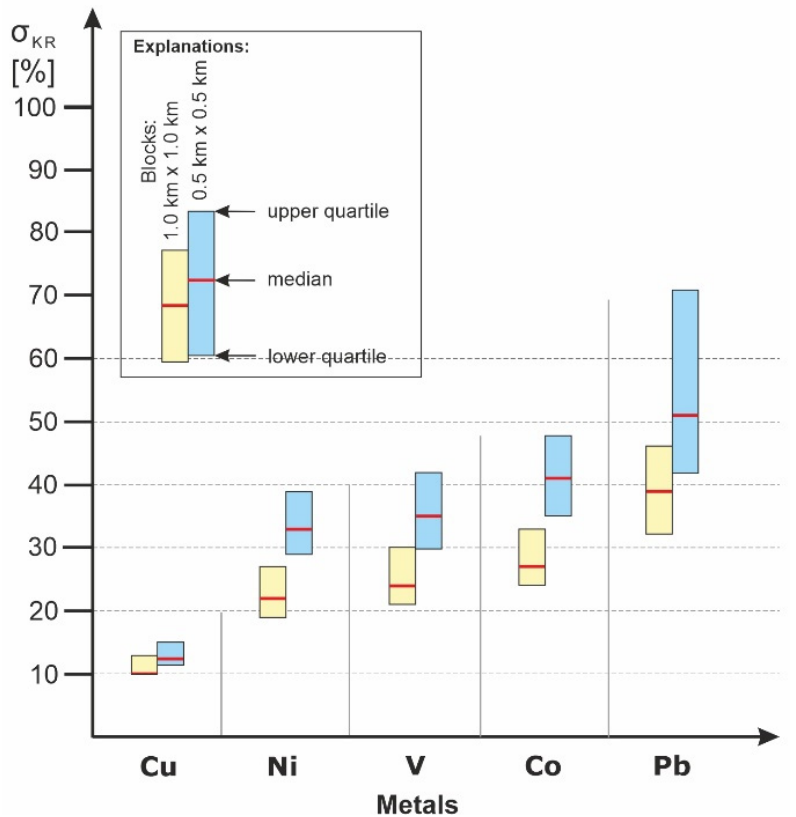
Figure 13. The ranking of the accuracy of the estimation of the average abundance of Cu and accompanying elements in blocks with an area of 0.25 and 1.0 km 2 in the Rudna deposit, expressed with the use of quartiles of standard block kriging relative error ( σ KR ).